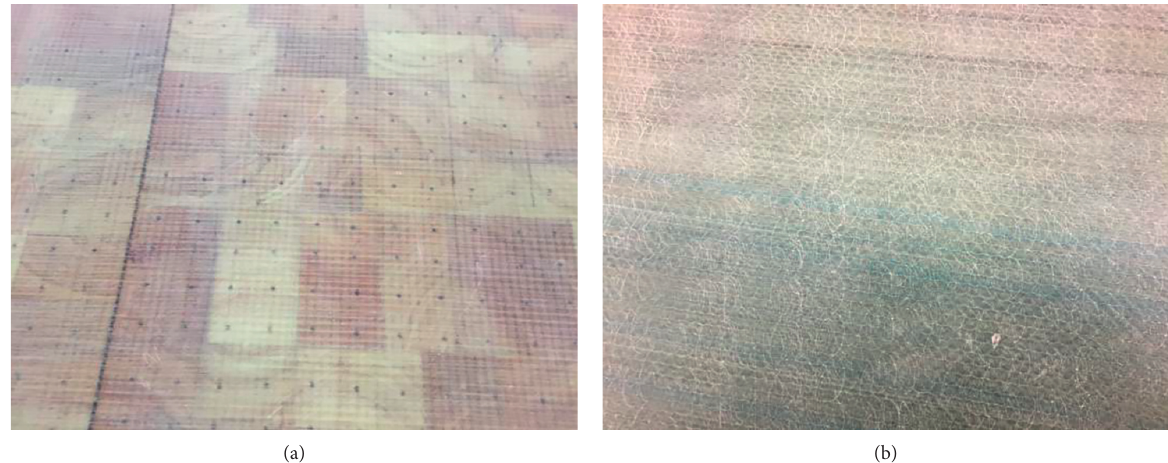
Figure 19: (a). Blade surface before sandblasting. (b). Blade surface after sandblasting.